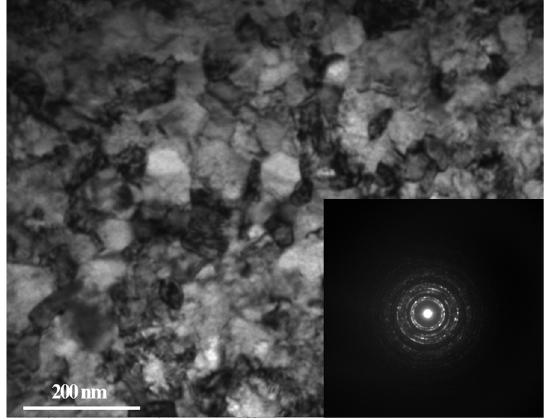
Figure 5. TEM image of the surface nanocrystalline layer of the HESPed sample.